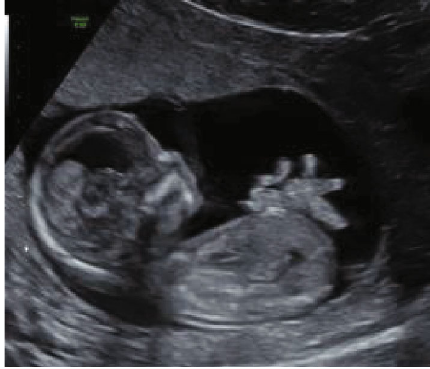
Figure 1: Gastroschisis at 13 weeks.